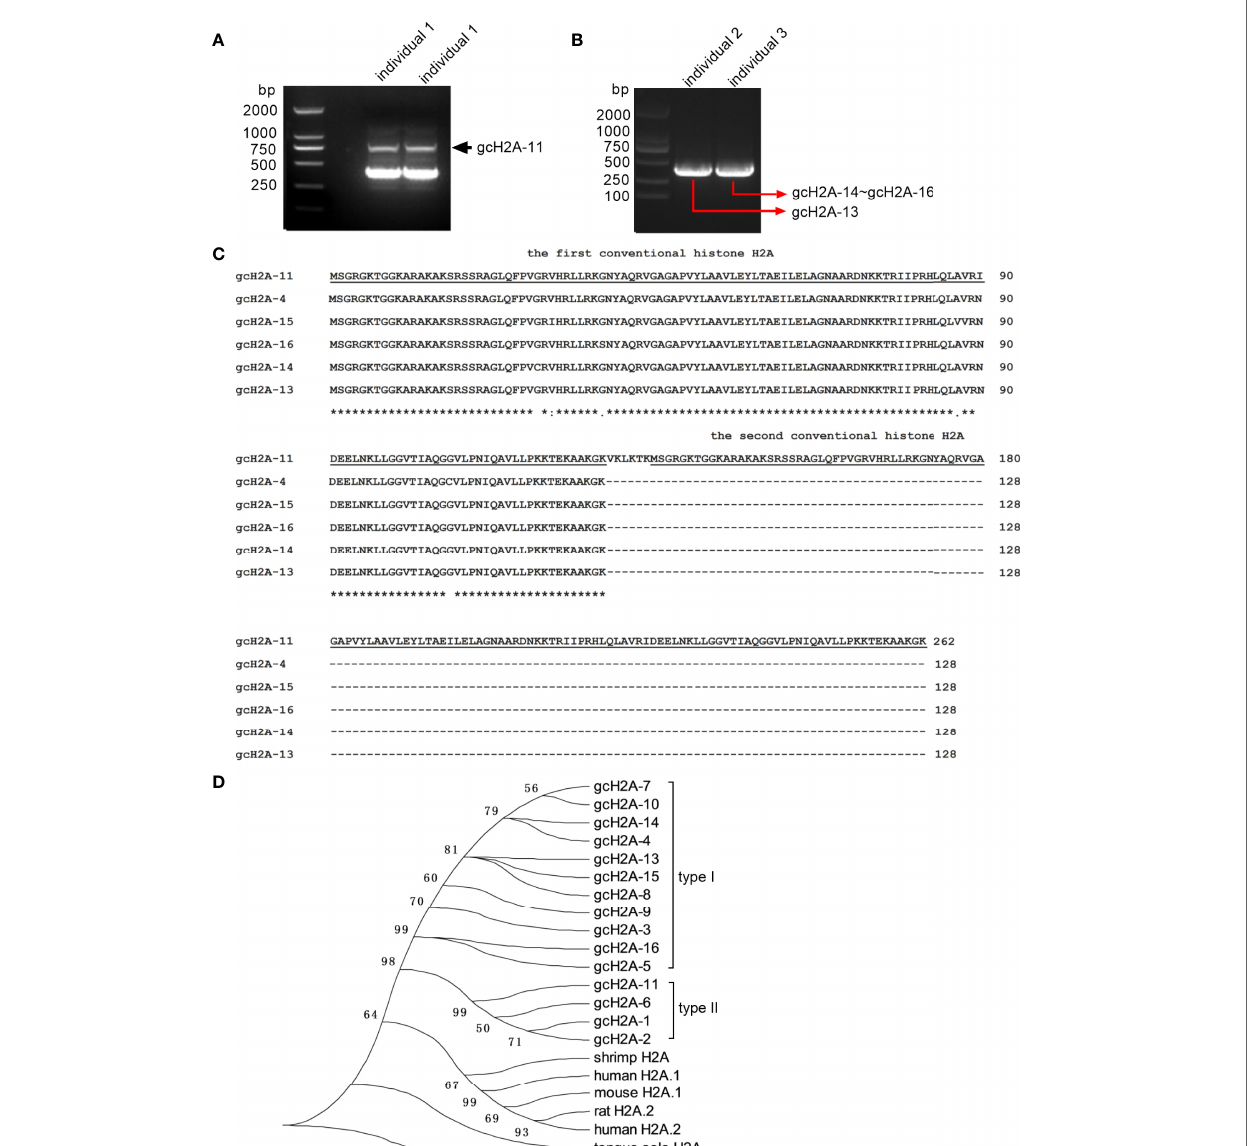
proliferation of F. columnare only at 6 hpi ( Figures 2K, L ). The numbers of F. columnare in the control group transfected with empty plasmid were 3.5-fold than that transfected with gcH2A-6, and 3.0-fold than that transfected with gcH2A-7. Together, these data suggest that gcH2A-11, whose size of amino acid sequences is twice that of other histones H2A variants, has the highest antibacterial activity in vitro .